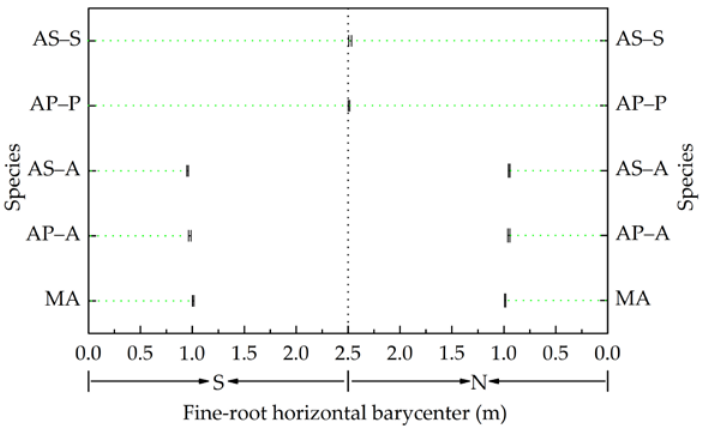
Figure 6. The fine-root horizontal barycenter (FRHB) for monocropped apple trees (MA),